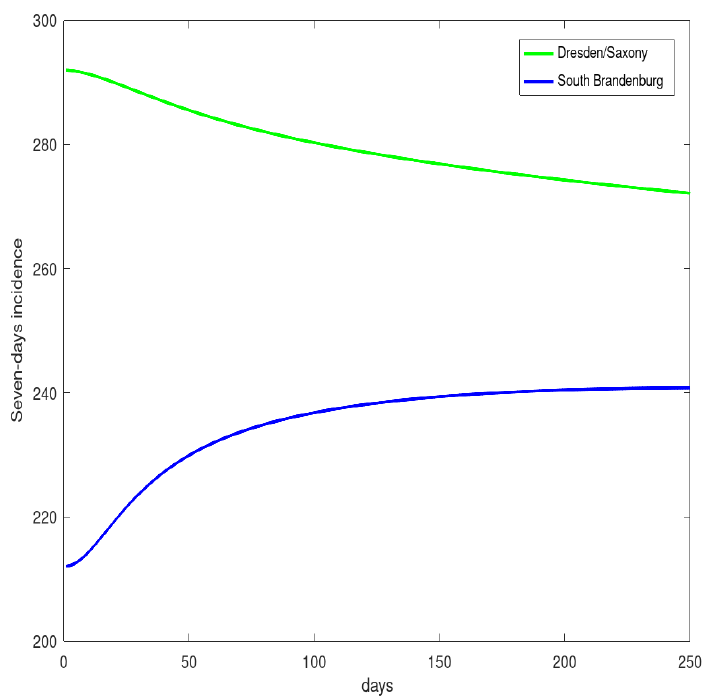
Figure 4. Time–history of s of Dresden/Saxony (upper curve) and South Brandenburg (bot- tom